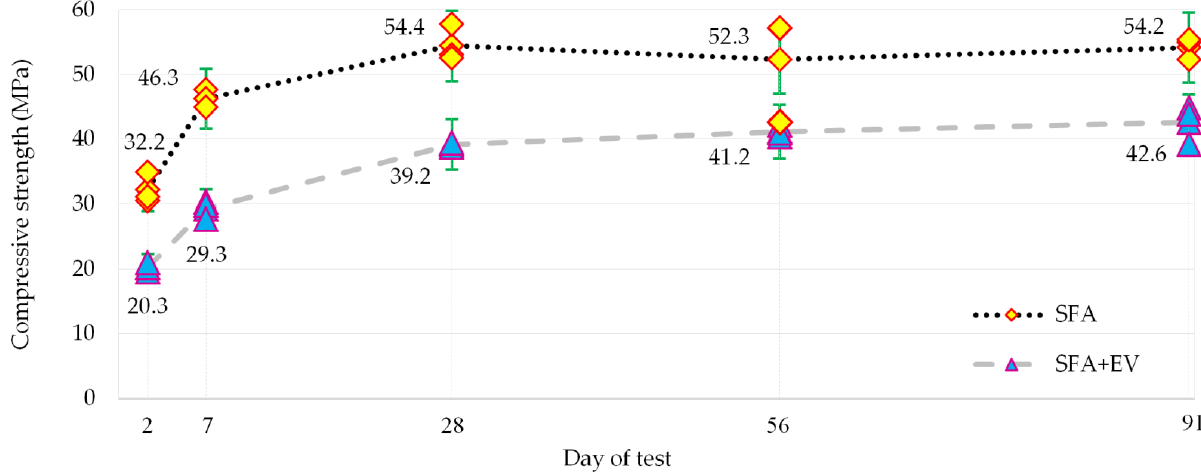
Figure 7. Depth of penetration of water under pressure: ( a ) cross-section of a specimens of SFA concrete; ( b ) surface of SFA+EV concrete and SFA concrete specimens after the test.